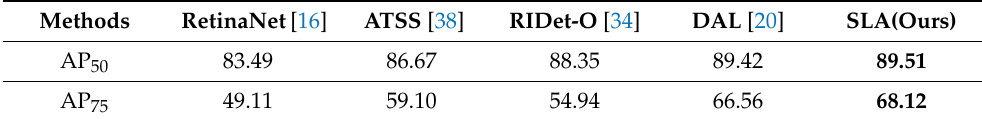
Table 6. Comparisons with high-quality detection performance on HRSC2016 dataset.